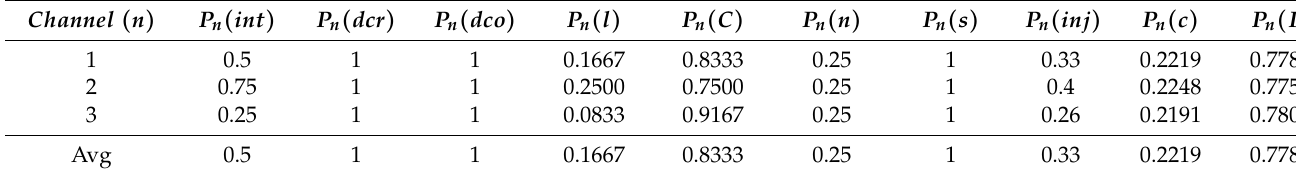
Table 4. Input and output values for a three-channel network.